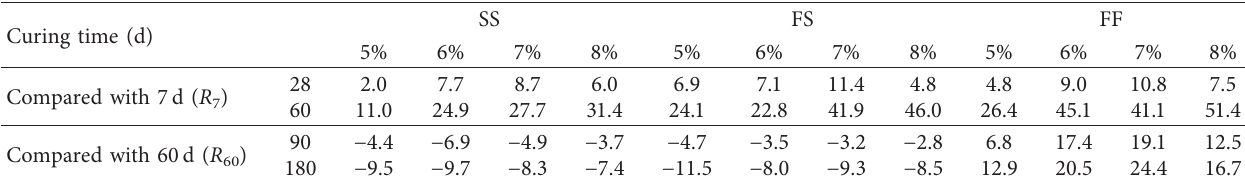
Figure 1: The unconfined compressive strength in different schemes. (a) The mixing and curing with seawater scheme (SS). (b) The mixing with fresh water and curing with seawater scheme (FS). (c) The mixing and curing with fresh water scheme (FF). Table 7: Change of the compressive strength